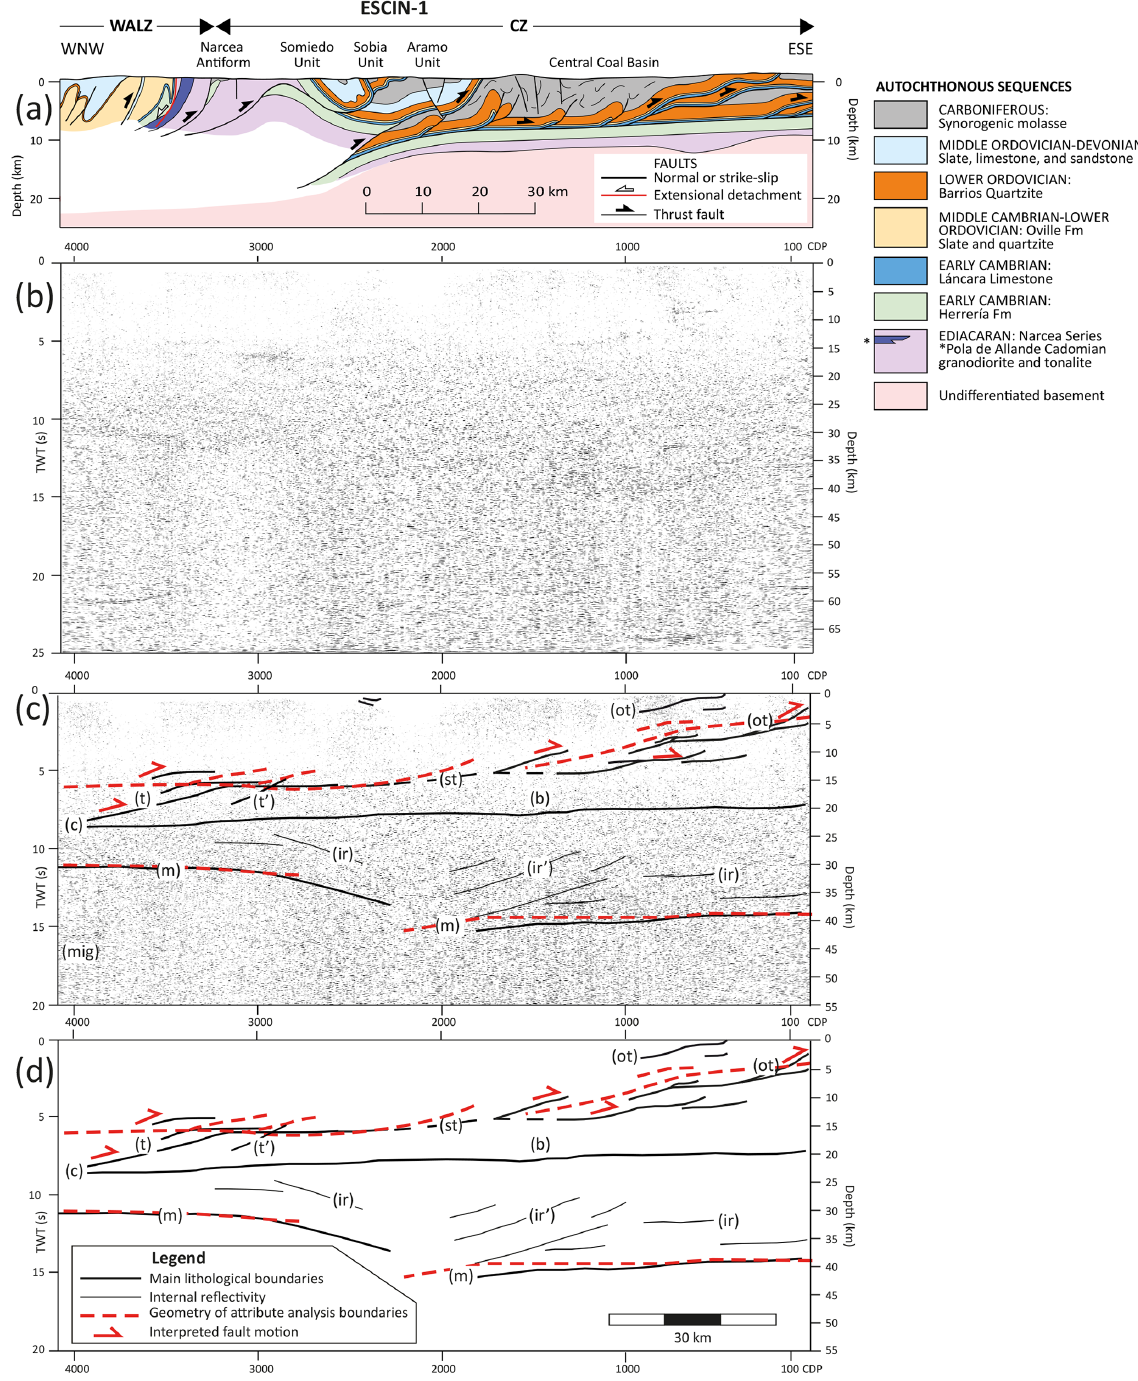
Figure 3. Cross section (a) and depth-converted time-migrated section ( v = 5600m/s) along the NI seismic profile ESCIN-1 (Fig. 1), with- out (b) and with (c) interpretation. A sketch of the most important features is presented in panel (d) . The abbreviations used in the figure are as follows: CDP is the common depth point, TWT is the two-way travel time, WALZ is the West Asturian-Leonese Zone, and CZ is the Cantabrian Zone. The position of the Narcea Antiform is indicated. Red dashed lines represent the boundaries provided by chaos and variance attribute analyses. The nomenclature for reflections is as follows: (ot) denotes outcropping thrusts, (t) denotes thrusts affecting the basement, (b) is undifferentiated basement, (st) is sole thrust, (c) is top of the lower crust, (ir) is the lower crust internal reflectivity, (m) is the Moho, and (mig) denotes curved features resulting from the migration of discontinuous reflections. Depth conversion is based on migration